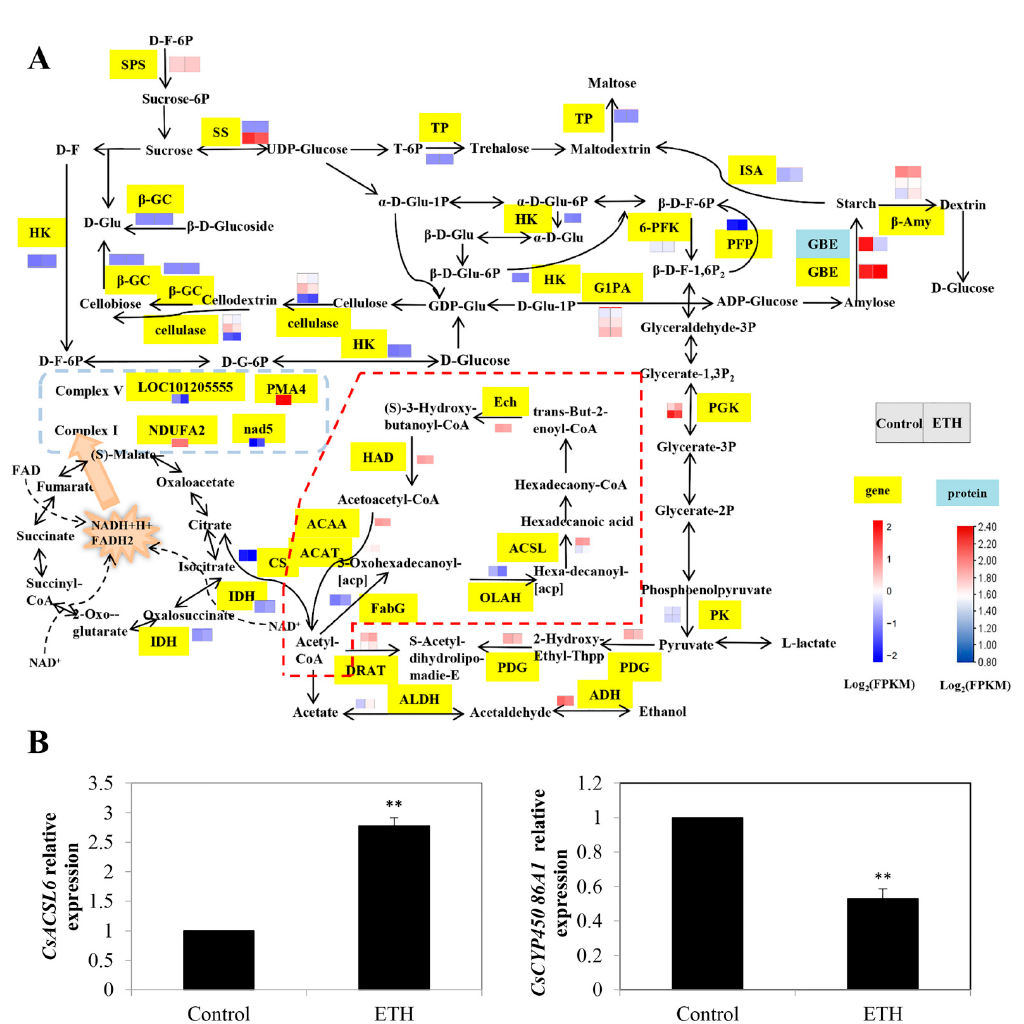
Figure 4. Identification and validation of key DEGs in fatty acid biosynthesis and fatty acid degradation during adventitious root development in cucumber. ( A ) Expression patterns of genes and proteins for fatty acid biosynthesis and fatty acid degradation in carbon metabolism during adventitious root development in cucumber. The dashed box represents fatty acid biosynthesis and fatty acid degradation. Annotations of genes and proteins are available in Supplementary Table S7. Black characters with yellow background are genes, whereas black characters with blue background are proteins. The two squares under the names of genes or proteins indicate the change in abundance of the control and ETH. A red square means up-regulation, whereas a blue square means down-regulation. ( B ) The expression profiles of 2 genes related to fatty acid biosynthesis and fatty acid degradation during adventitious root development in cucumber. Double asterisk (**) indicates the significance at p < 0.01. The bar represents the value of standard error. Values represent the mean ± SE of three replicates. Each experiment was repeated three times independently.